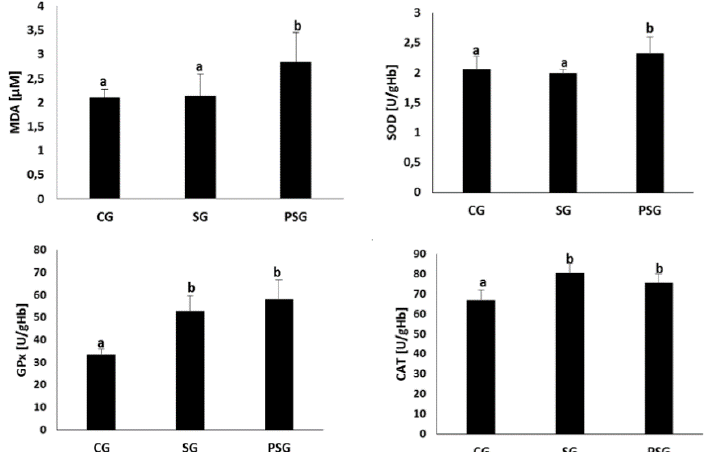
Figure 1. E ff ect of frequent changes in diet or periodic starvation on plasma malonyldialdehyde (MDA) concentrations and erythrocyte superoxide dismutase (SOD), glutathione peroxidase (GPx), catalase marked with di ff erent letters in the same line are statistically di ff erent, p ≤